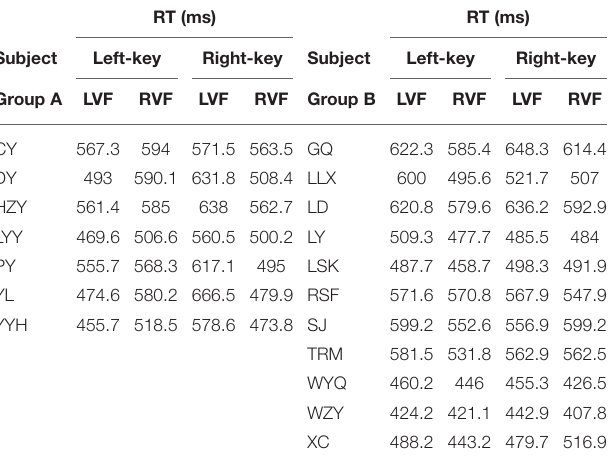
TABLE 1 | The mean RTs under different conditions in orientation discrimination task.